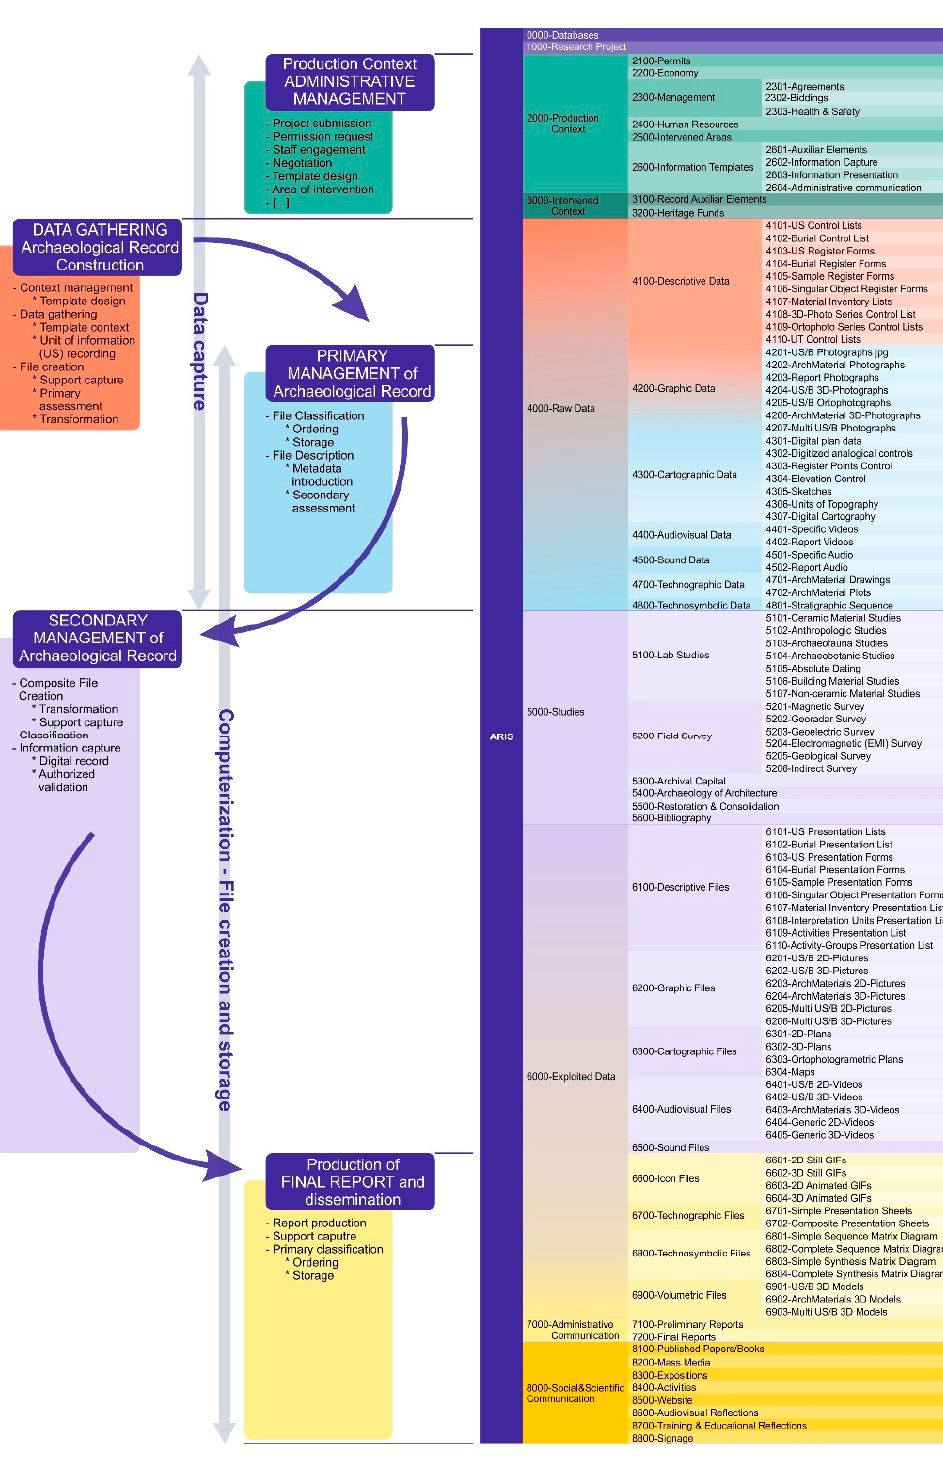
Figure 6. Classification chart of series, folders and files of the ARIS according to the main diagnosed processes of information management.